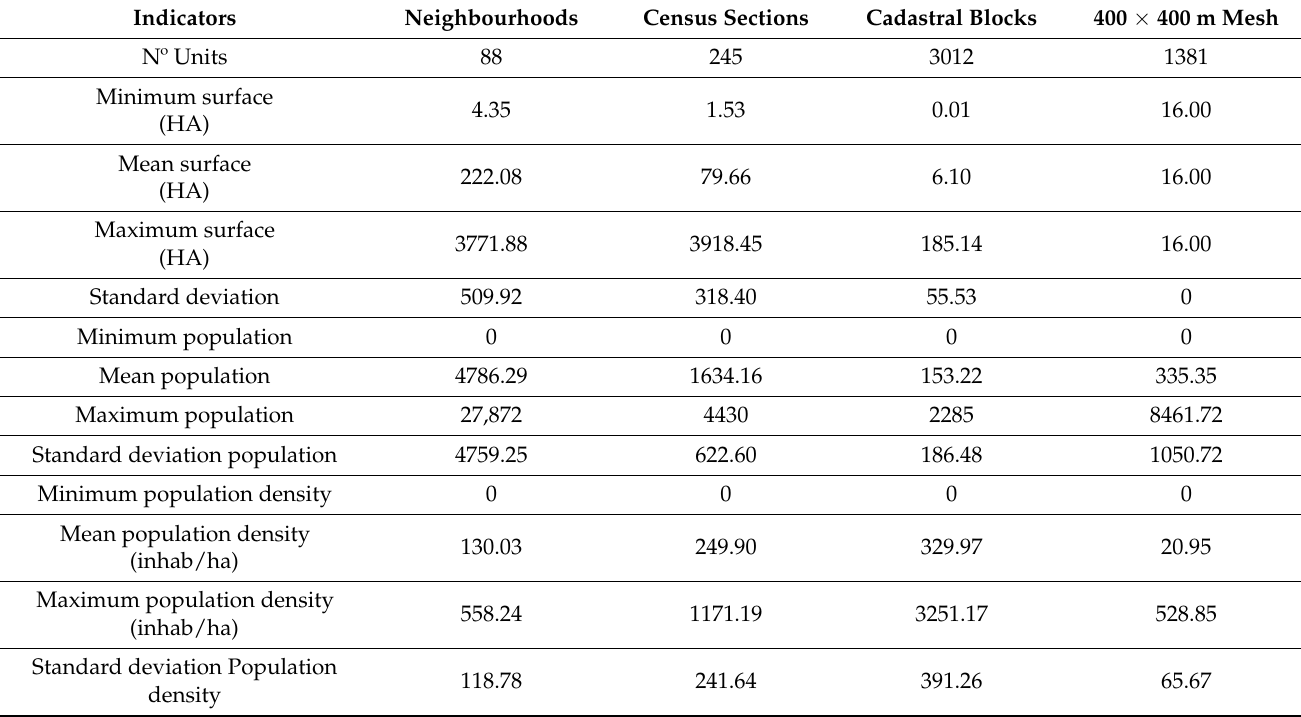
Table 1. Description of the zones considered.